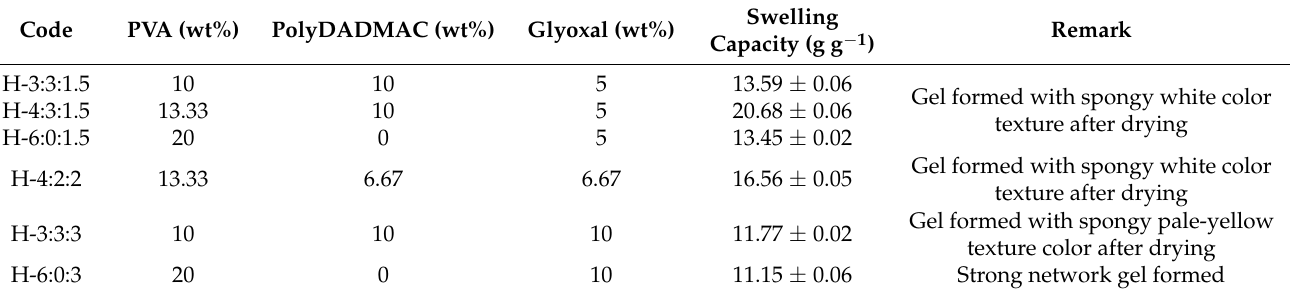
Table 1. Composition and swelling ratio of the prepared